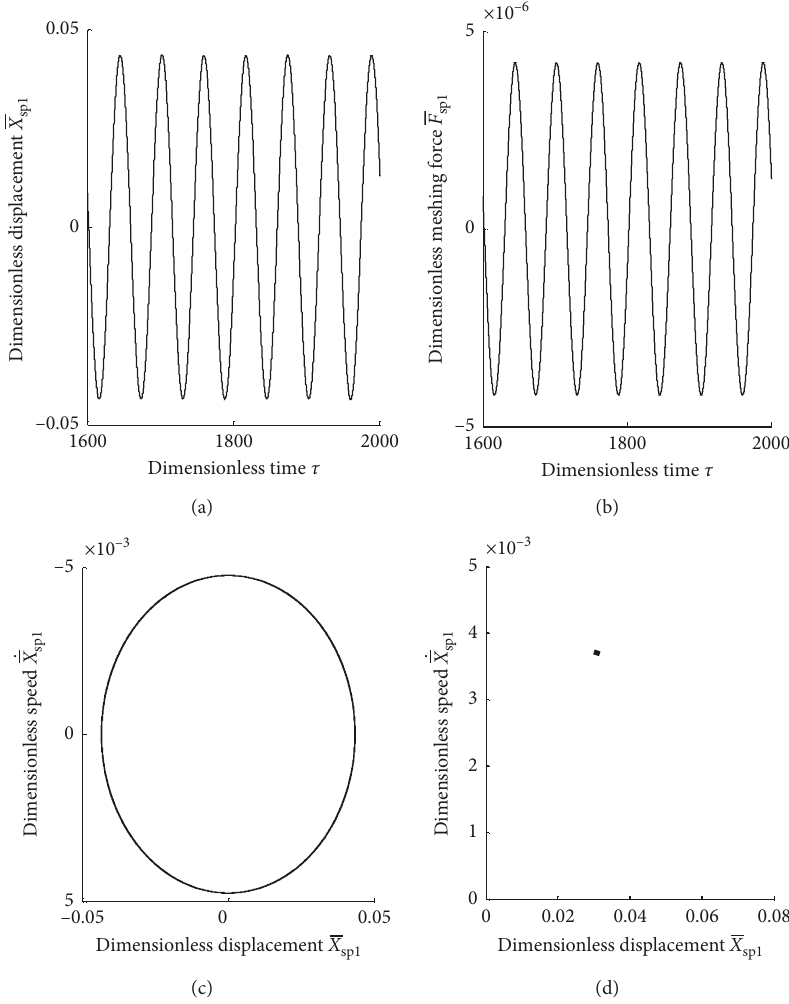
Figure 3: Process diagrams of response, phase diagram, and Poincar´e section under b � 0 μ m for differential stage. (a) Time process diagram of displacement response. (b) Time process diagram of meshing force response. (c) Phase diagram. (d) Poincar´e